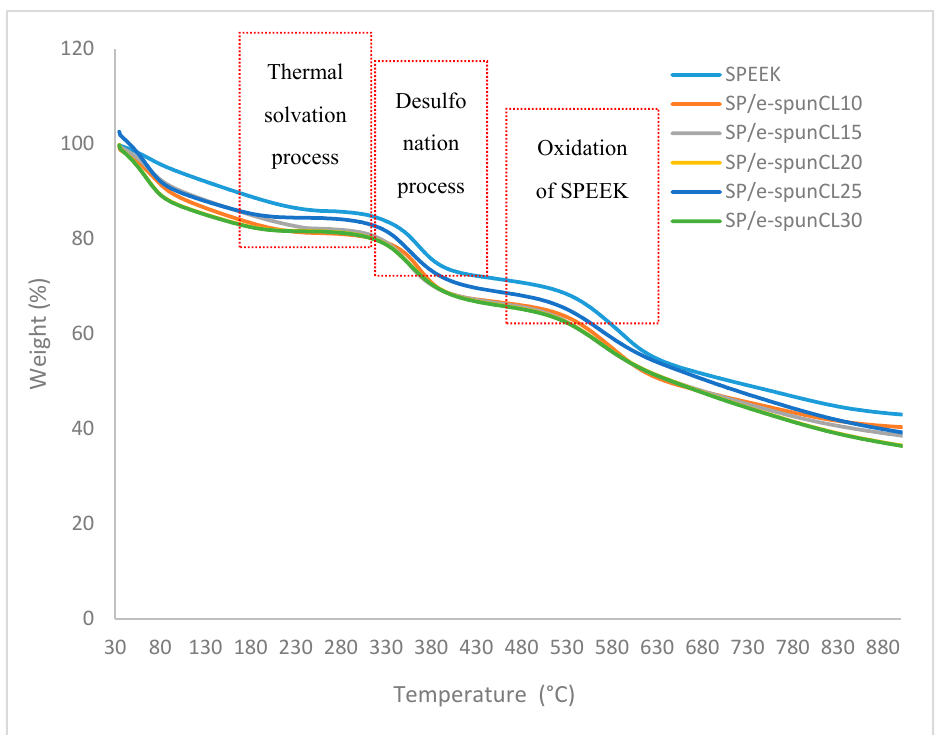
Figure 3. TGA of SPEEK and SP/e-spunCL membranes with various formulations.